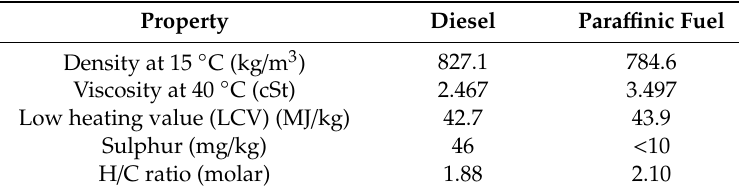
Table 1. Fuel properties.